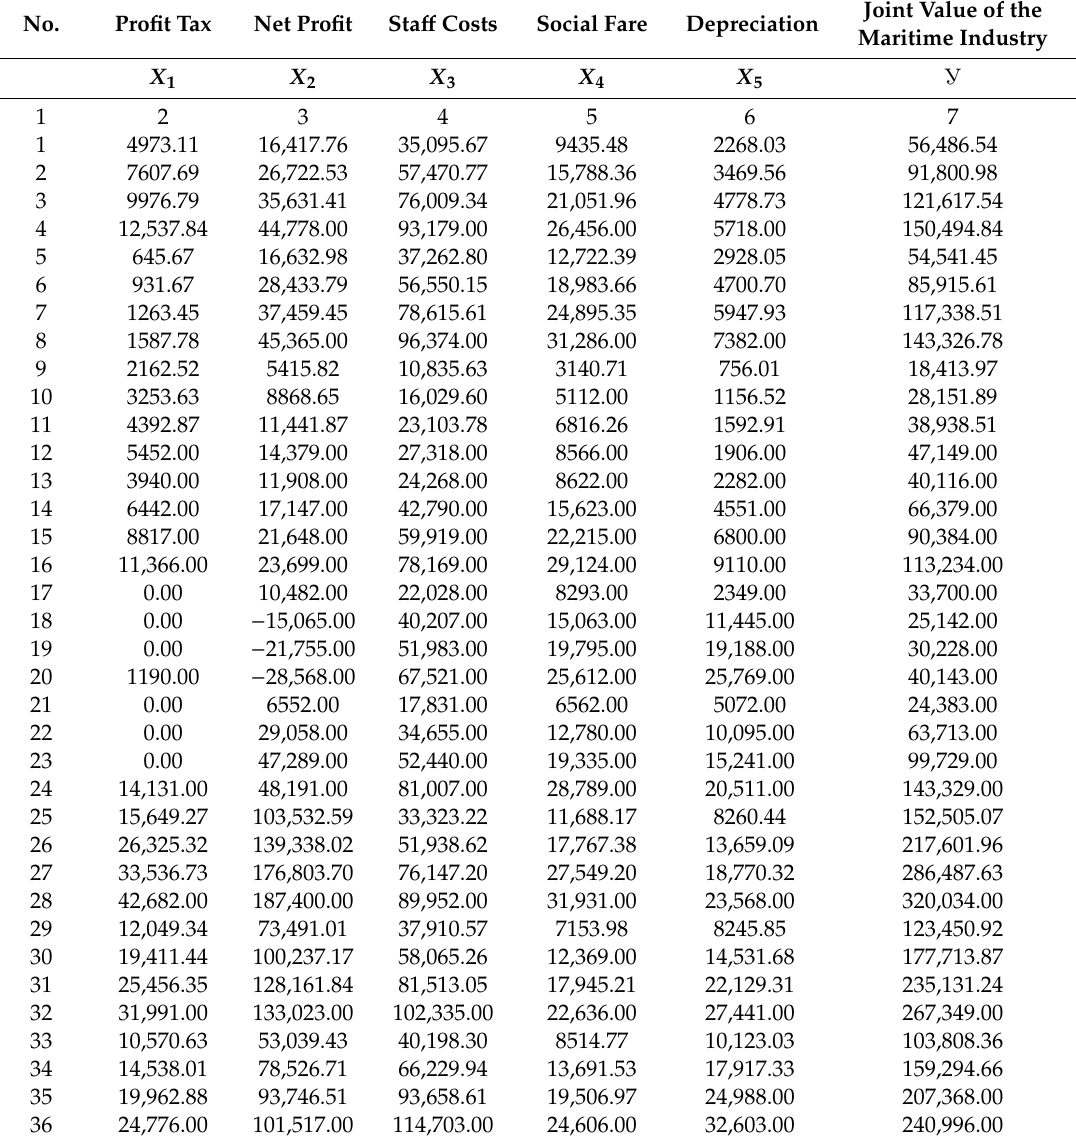
Table 1. Output data for a multifactor model of joint value created in the maritime industry, in thousands of